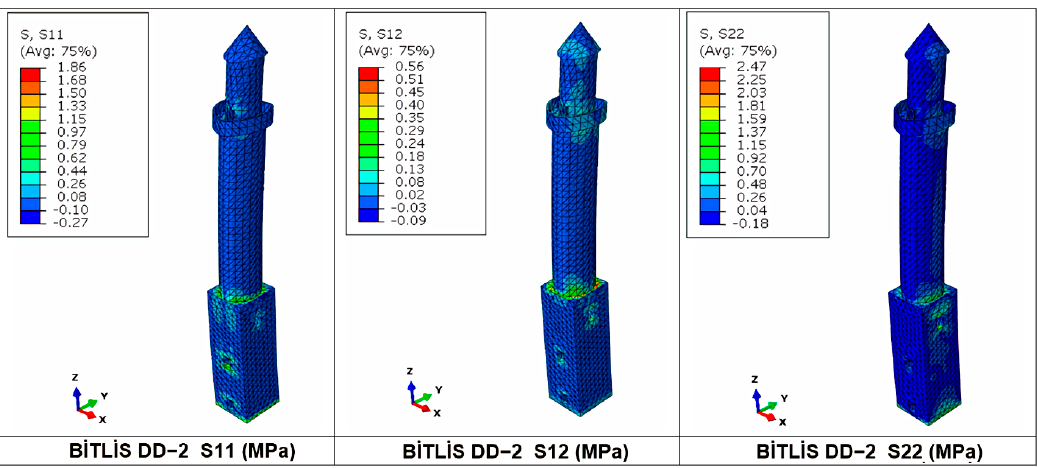
Buildings 2022 , 12 , x FOR PEER REVIEW Figure 22. Relative stresses for DD − 1 ground motion level. Figure 22. Relative stresses for DD − 1 ground motion level.